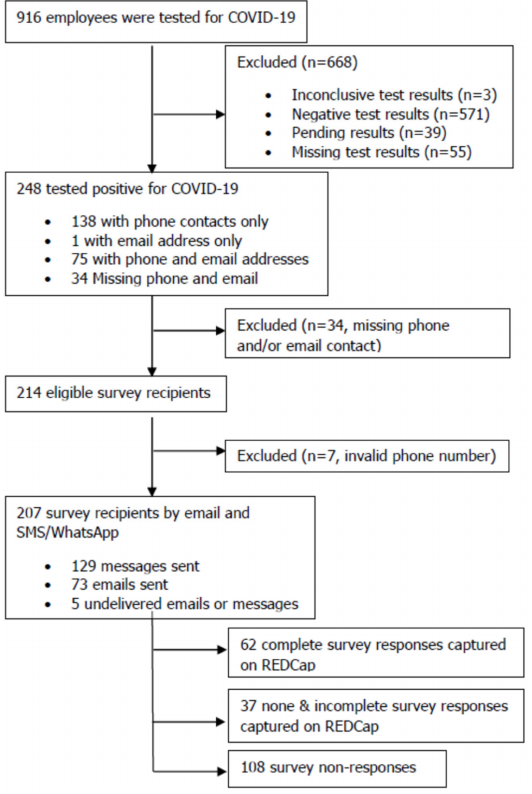
Figure 1. Participant flow chart. Data for frontline workers who had tested positive for SARS-CoV-2 by RT-PCR between 5 January 2020 and 7 February 2021 were extracted from the RTC database. Exclusion and inclusion criteria were applied resulting in 207 eligible participants.